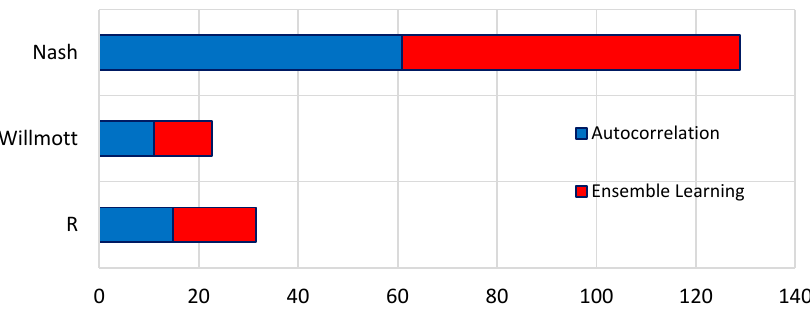
Figure 7. Effect of preprocessing against evaluation criteria.